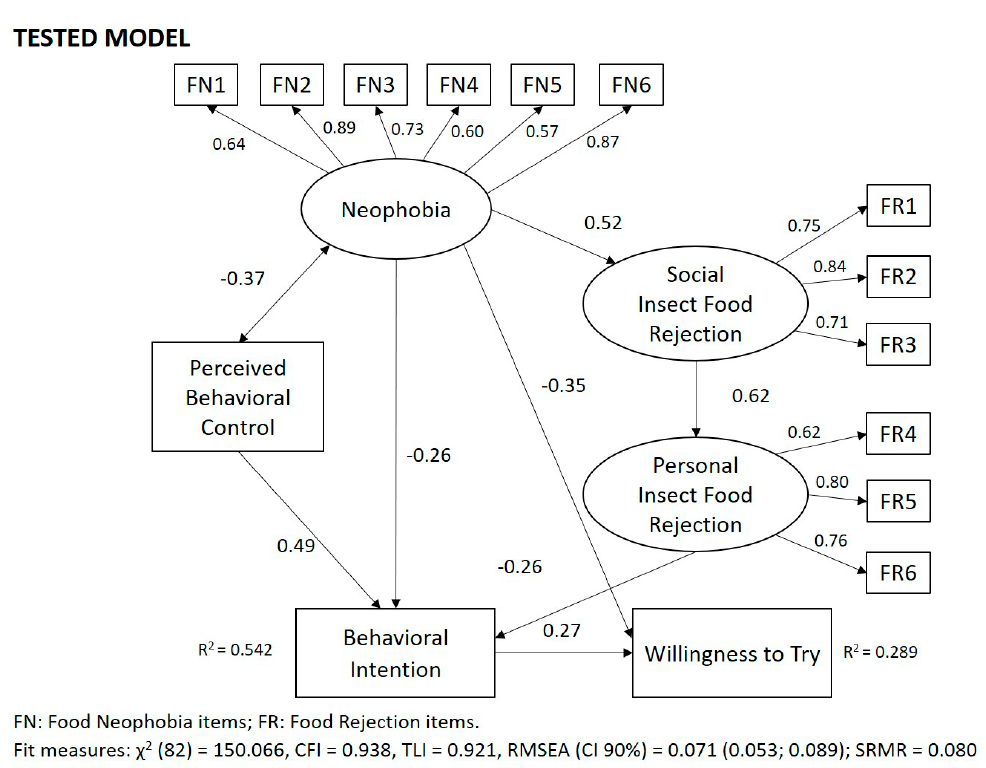
Figure 2. The standardized regression coe ffi cients, explained variance (R 2 ), and fit measures.